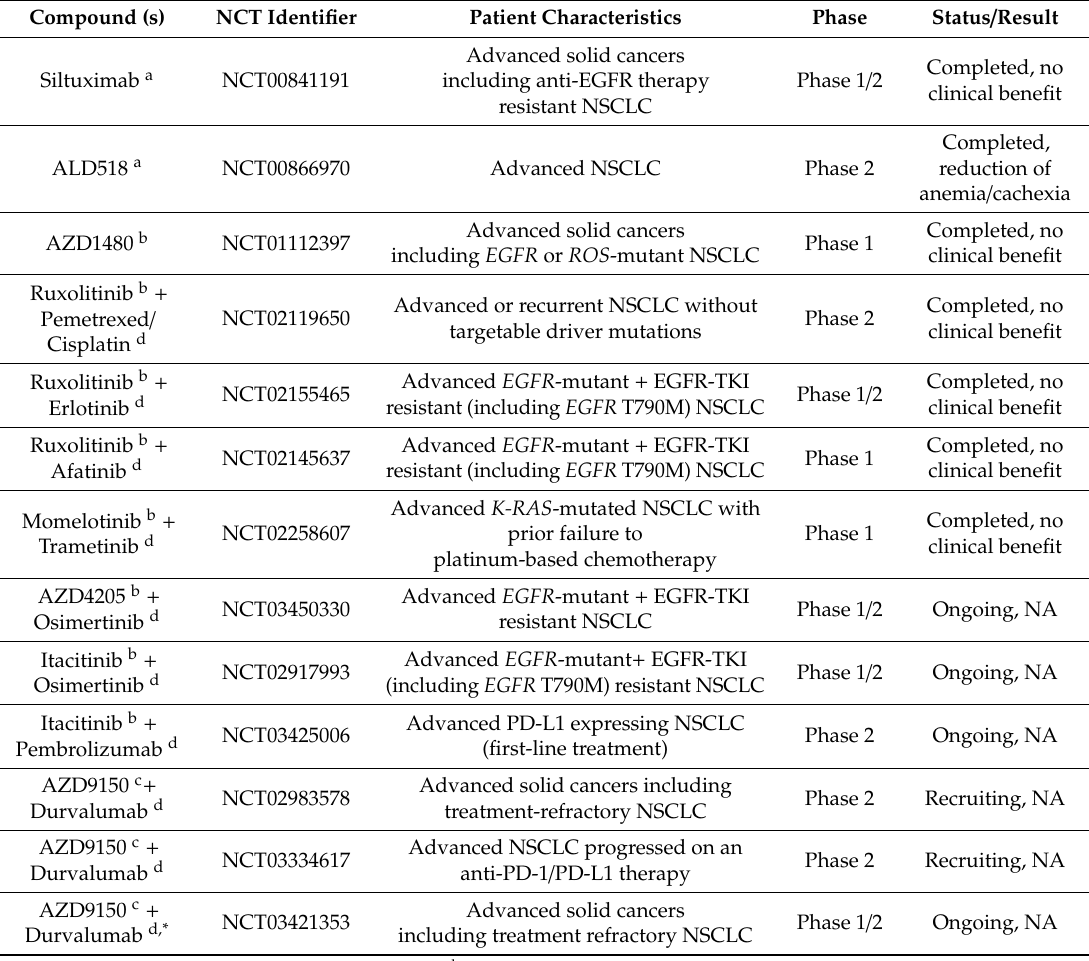
Table 1. Completed and ongoing clinical trials assessing STAT3 pathway inhibition in NSCLC; Source: